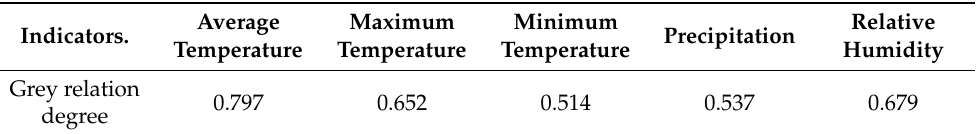
Table 1. Grey correlation degree analysis of domestic water consumption in Beijing and different indicators in Beijing.